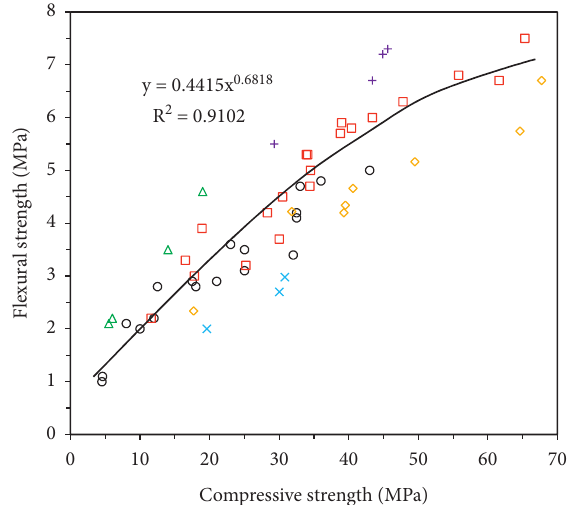
Figure 6: Relationship between compressive strength and flexural strength of HVFA mixtures, based on the data collected from relevant